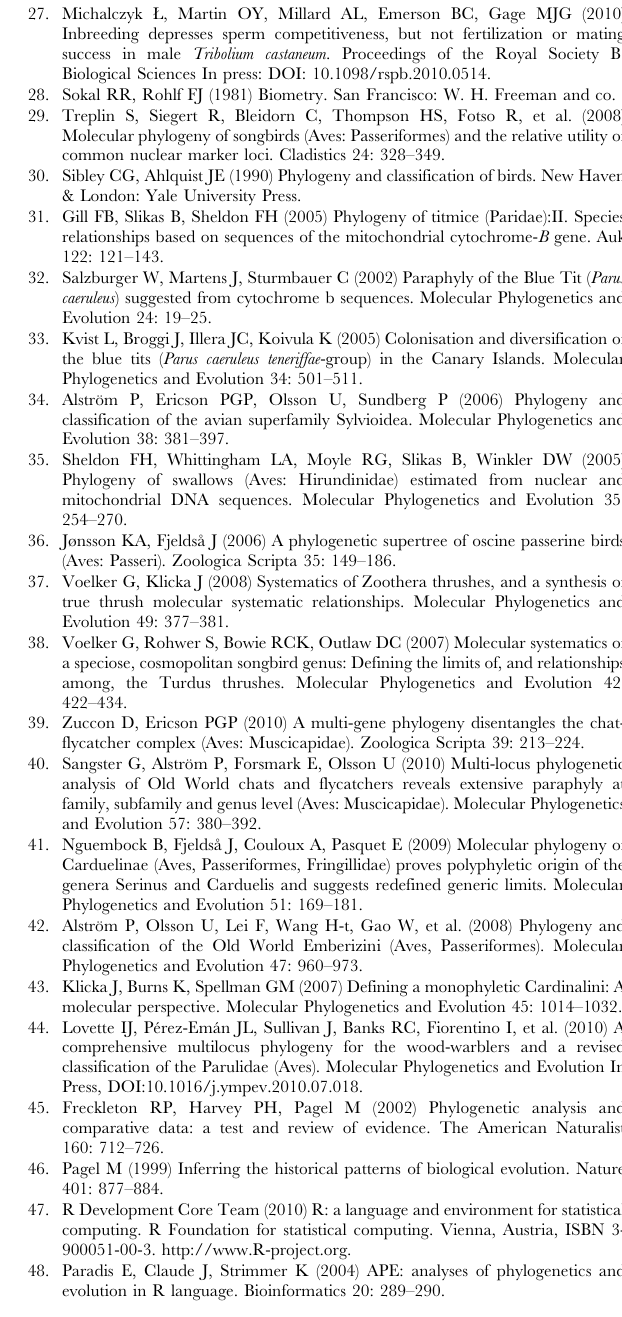
Table S1 Sperm length characteristics, relative testis size, predicted proportions of extrapair young from the CVbm index, and observed proportions of extrapair young in 55 passerine